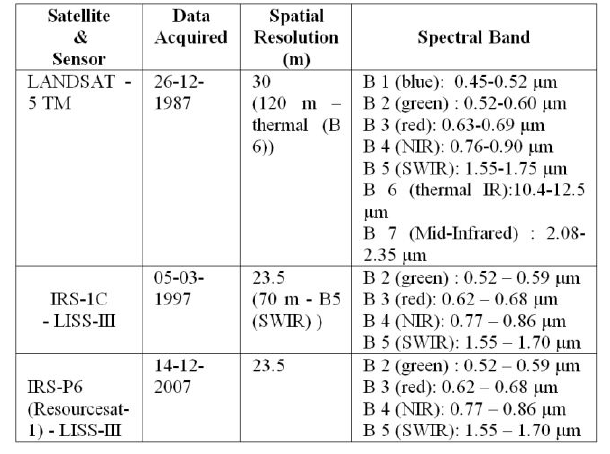
Table 1: Details of satellite data used in the study